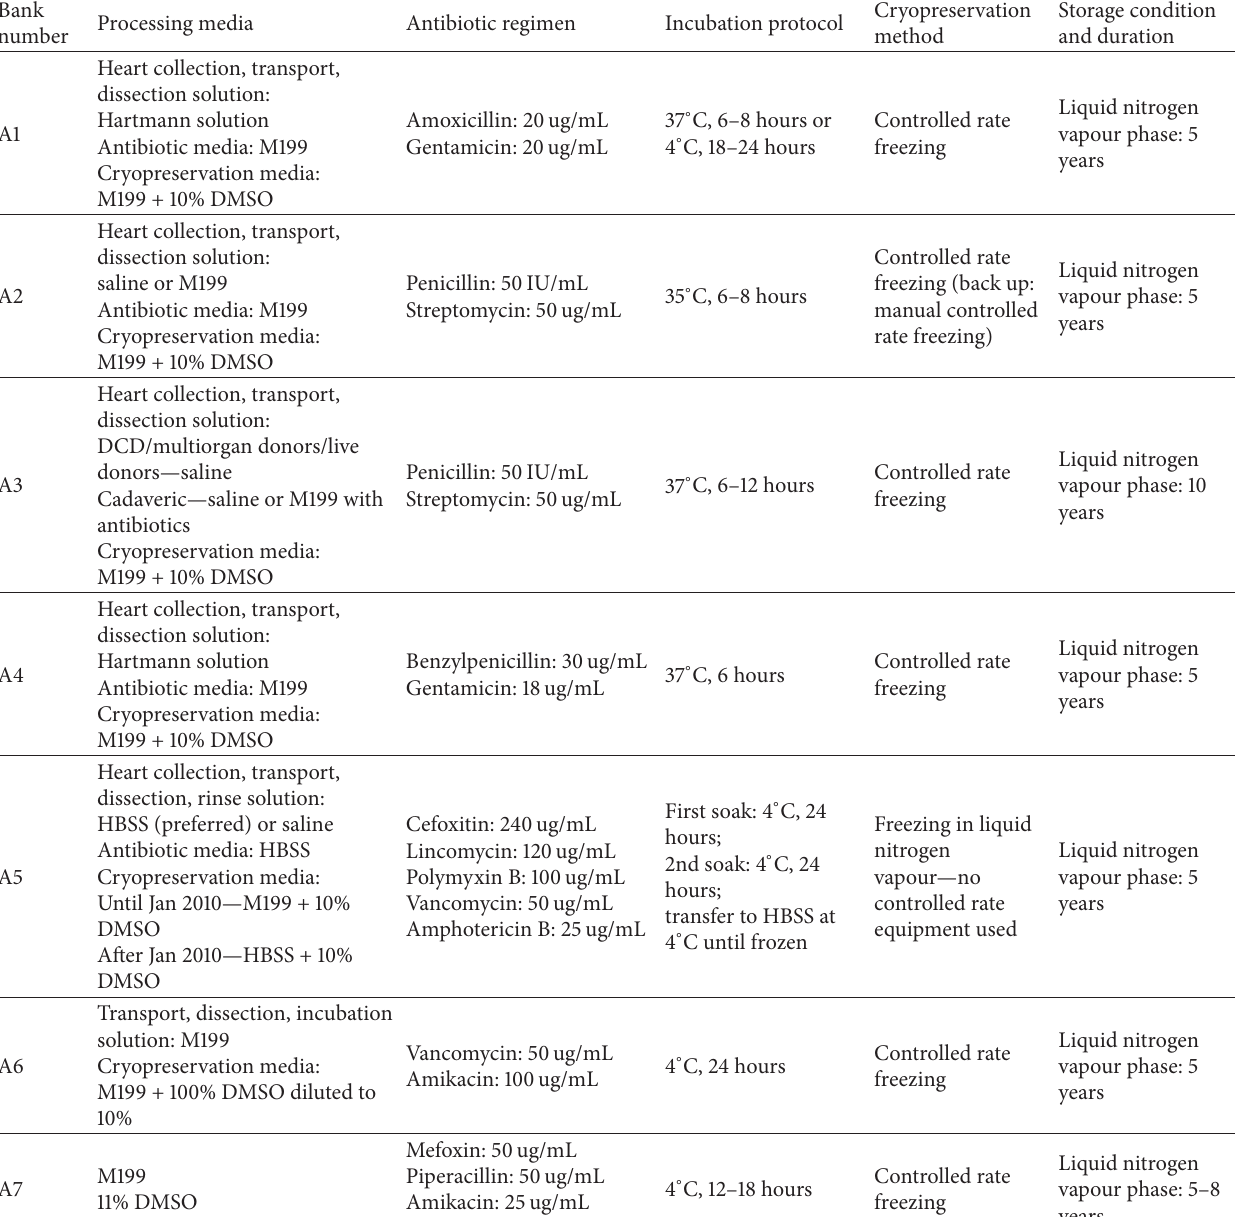
Table 3: Summary of heart valve processing protocols used by HVBs in Australasia and South